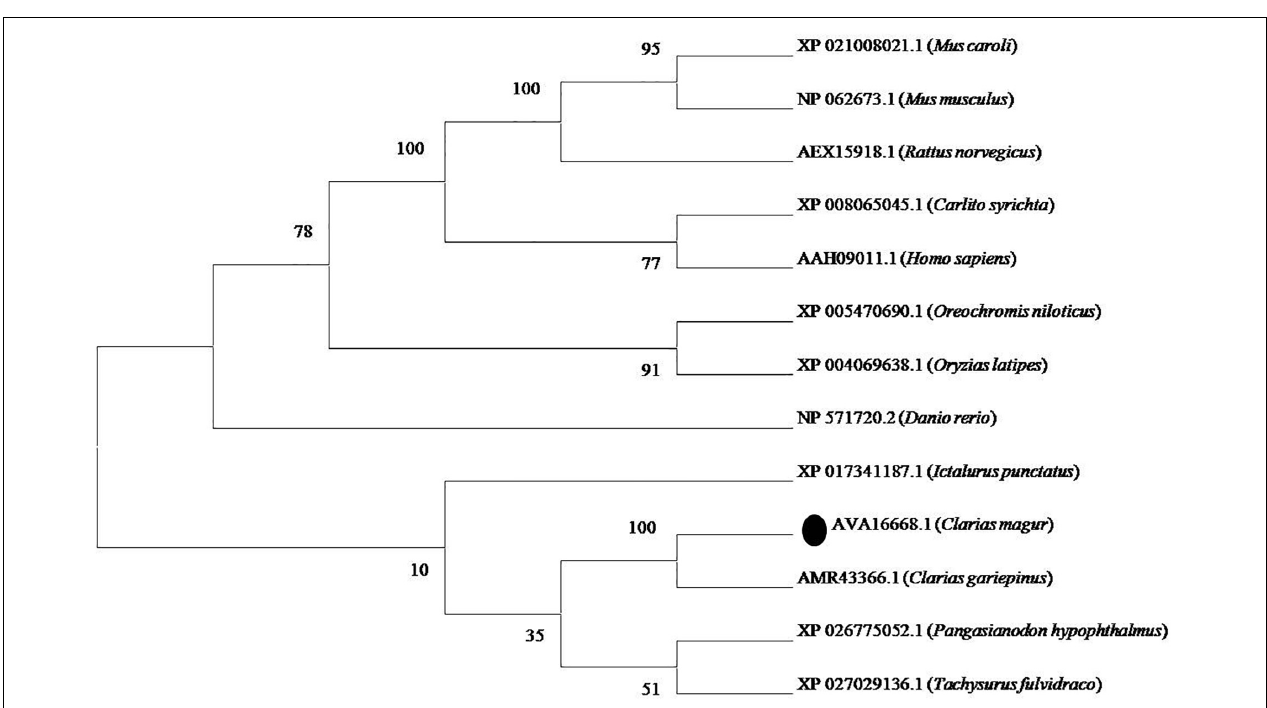
FIGURE 2 | Phylogenetic analysis of C. magur FADS2 putative protein was done using MEGA 7.0 software. Phylogenetic relationship with other piscine and selected mammalian FADS2 proteins. The evolutionary tree was formed using the neighbor-joining method and a bootstrap analysis with 1000 replicates was used to assess the strength of nodes in the tree. Accession numbers are given in the